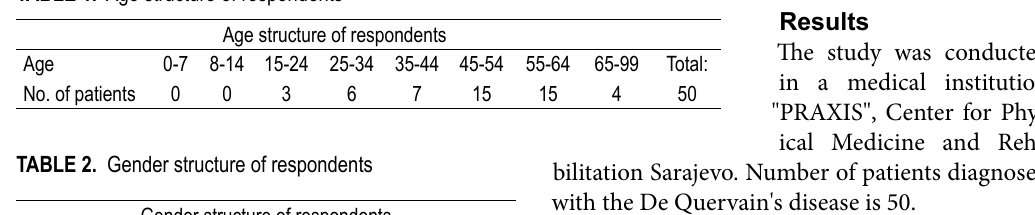
Table 1. age structure of respondents